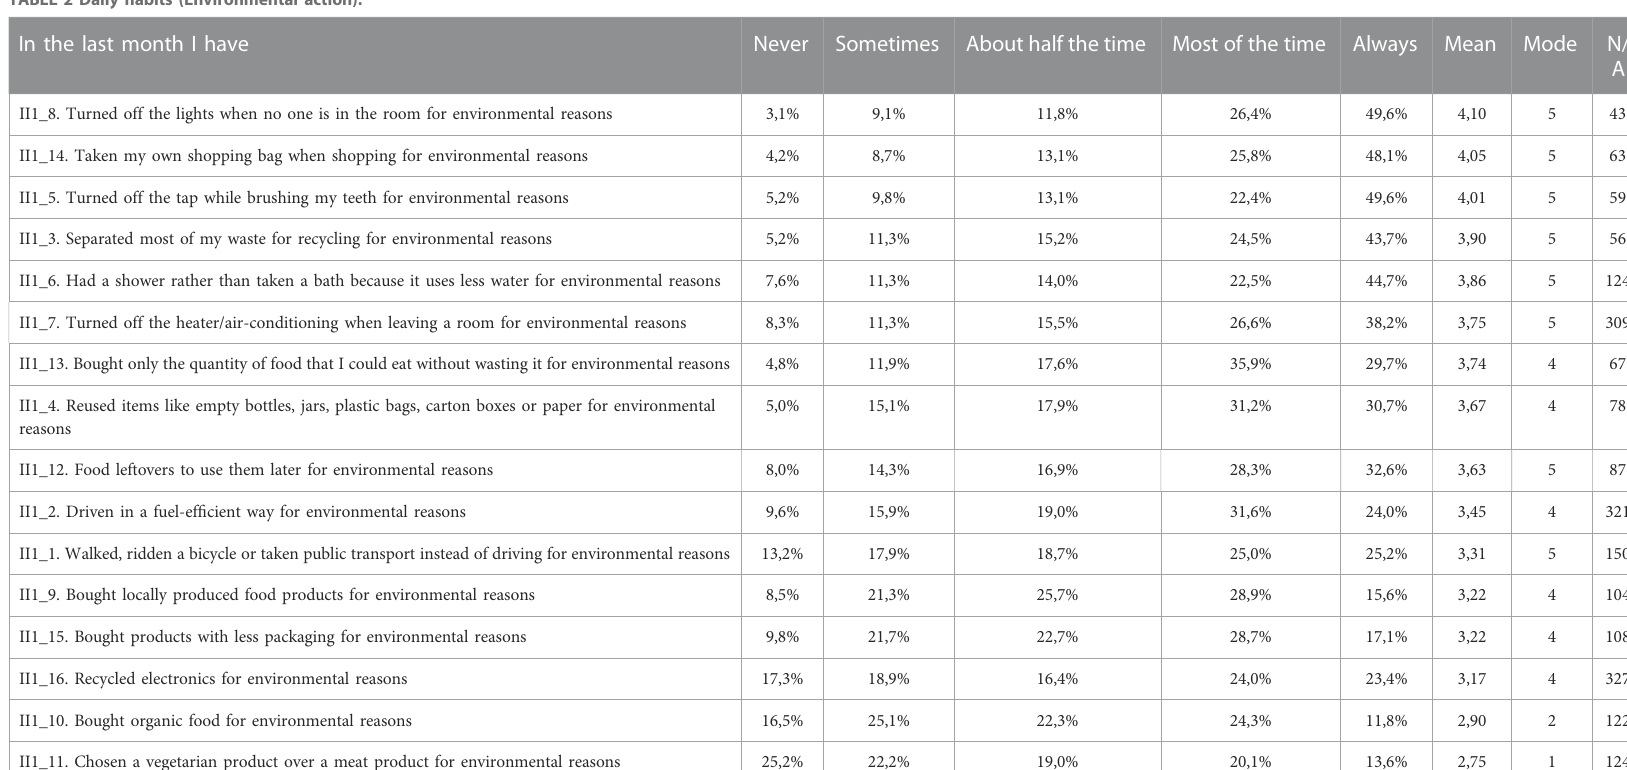
TABLE 2 Daily habits (Environmental action). In the last month I have Never Sometimes About half the time Most of the